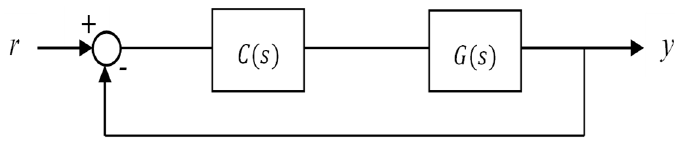
Figure 1. Closed loop control system.